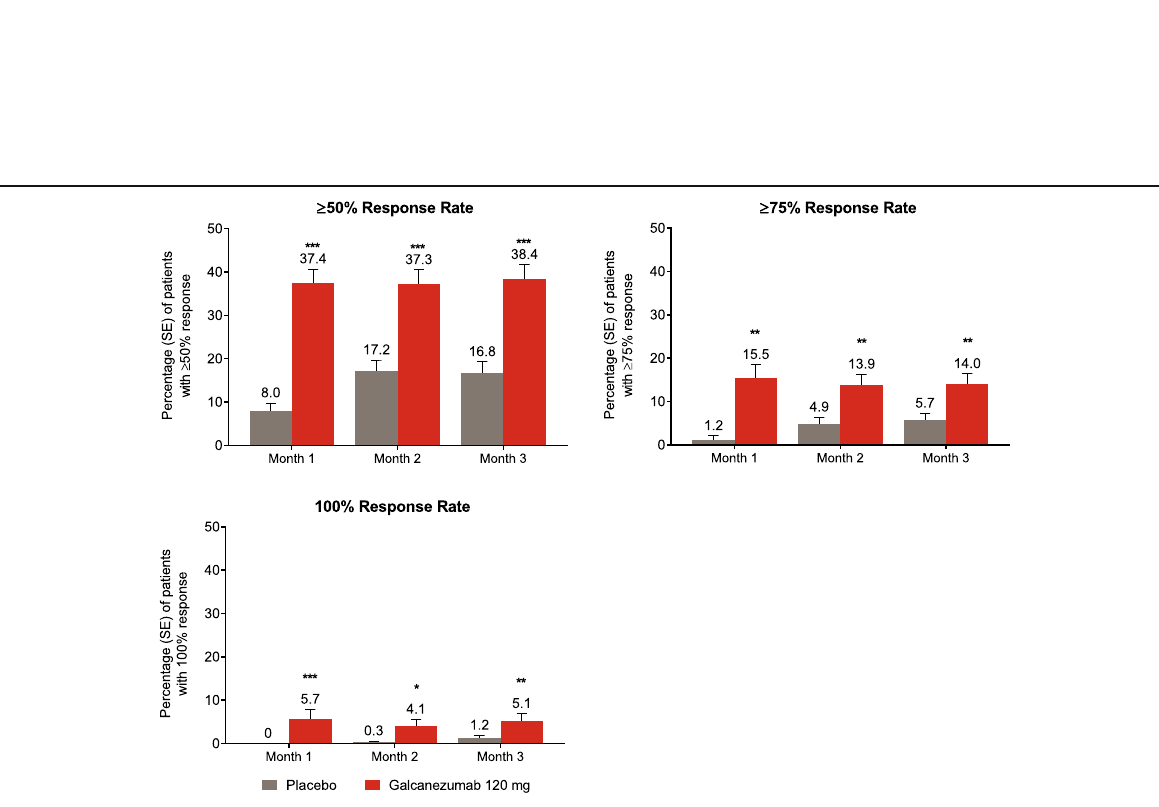
Fig. 4 Estimated mean percentage of patients with ≥ 50%, ≥ 75%, and 100% reduction from baseline in monthly migraine headache days at months 1 – 3. * p < 0.05, ** p < 0.01, *** p ≤ 0.0001 vs placebo. SE standard